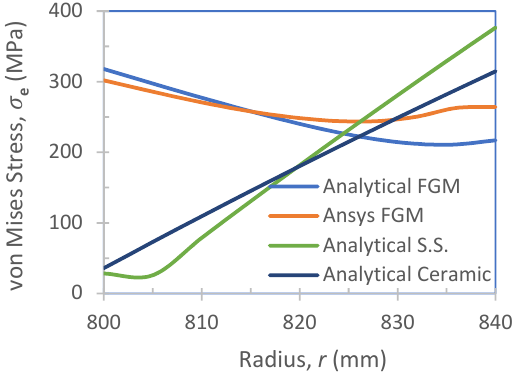
Figure 10. The variation of von Mises stress with cylinder radius.